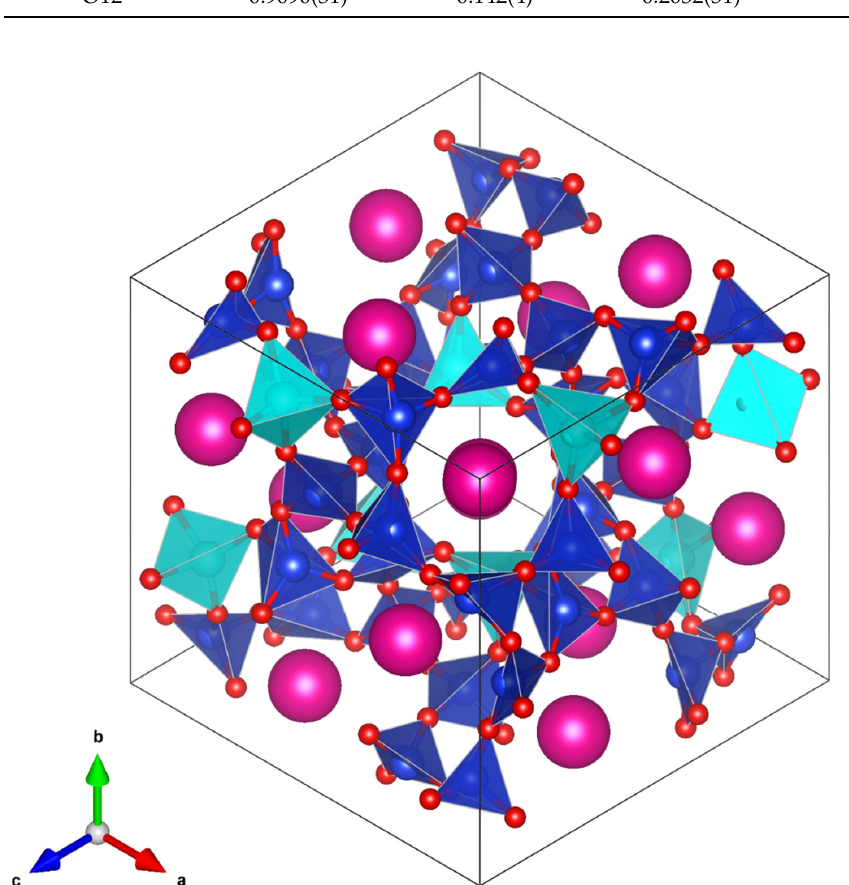
Figure 2. VESTA plot showing the ambient temperature Pbca orthorhombic crystal structure of Rb 2 CoSi 5 O l2 . Pink spheres represent Rb + cations, red spheres represent O 2 − anions, dark blue tetrahedra represent SiO 4 units and light blue tetrahedra represent CoO 4 units. Table 1. Refined atomic coordinates for ambient temperature Rb 2 CoSi 5 O l2 .